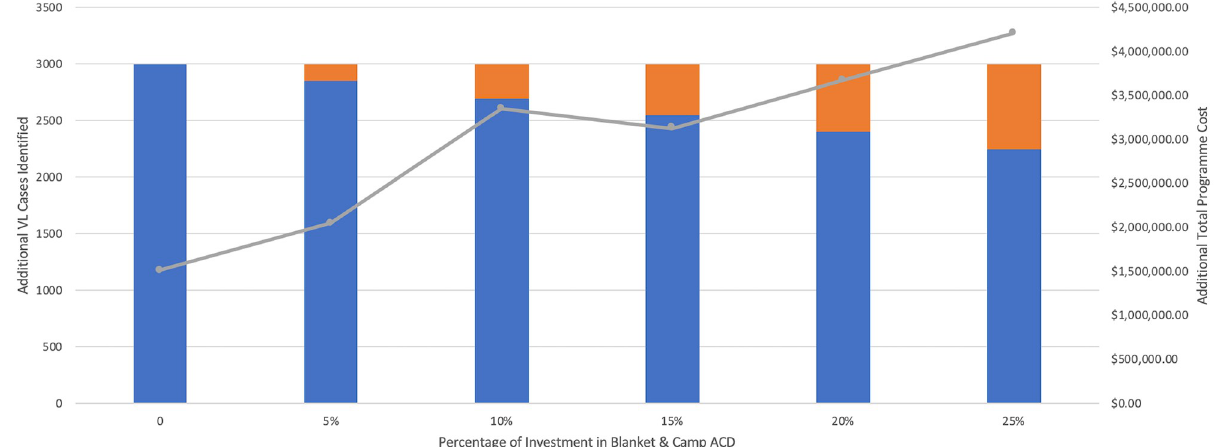
Fig 9. Cost of scaling up ACD to identify additional cases. Cost of scaling up index case-based (IC-B) and blanket & camp (B&C) ACD to identify 3,000 additional VL cases. Total programme cost includes both IC-B and B&C together, as if managed by a single funder.